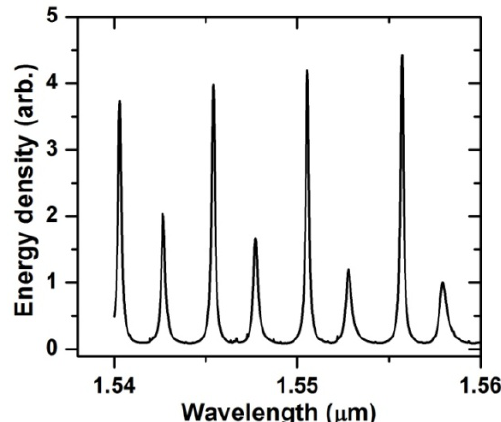
Figure 4. Resonance spectra of the ring for the OFRR (d = 100 μ m, t = 3 μ m, w = 2 μ m, g = 0 nm). The large peaks are for the first-order resonances while the small peaks are for the second-order